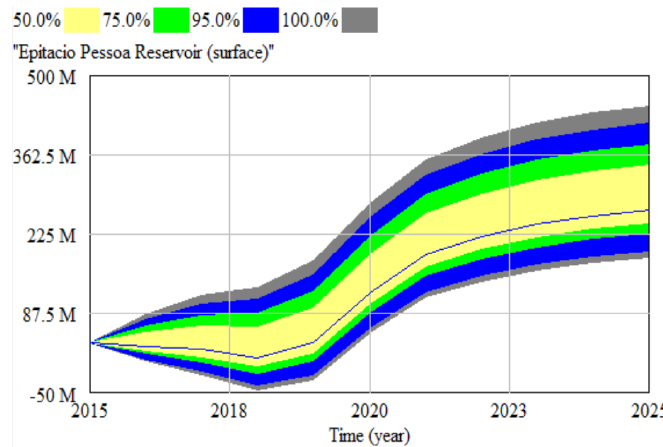
Figure 18. Monte Carlo simulation result for transposition of water between